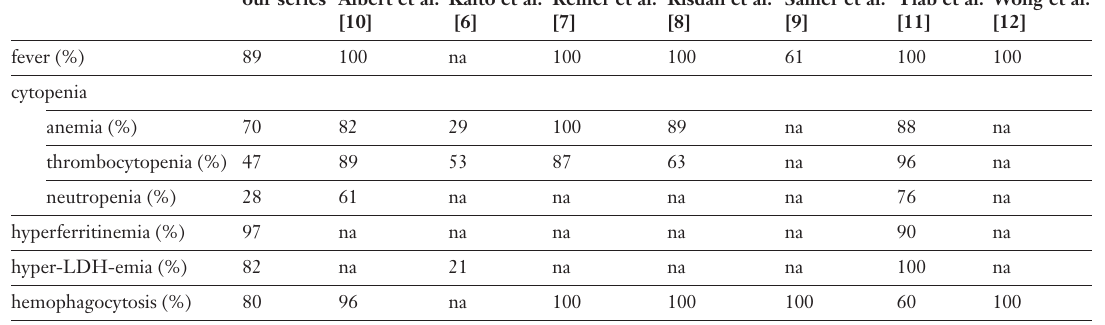
Table 2 Imashuku’s criteria for rMAS [1].